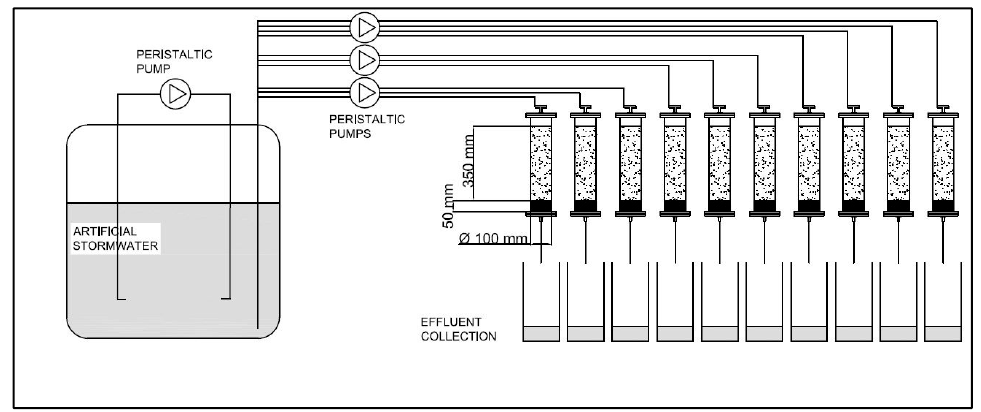
Figure 1. Schematic overview of the column setup with adsorbents placed at the bottom.